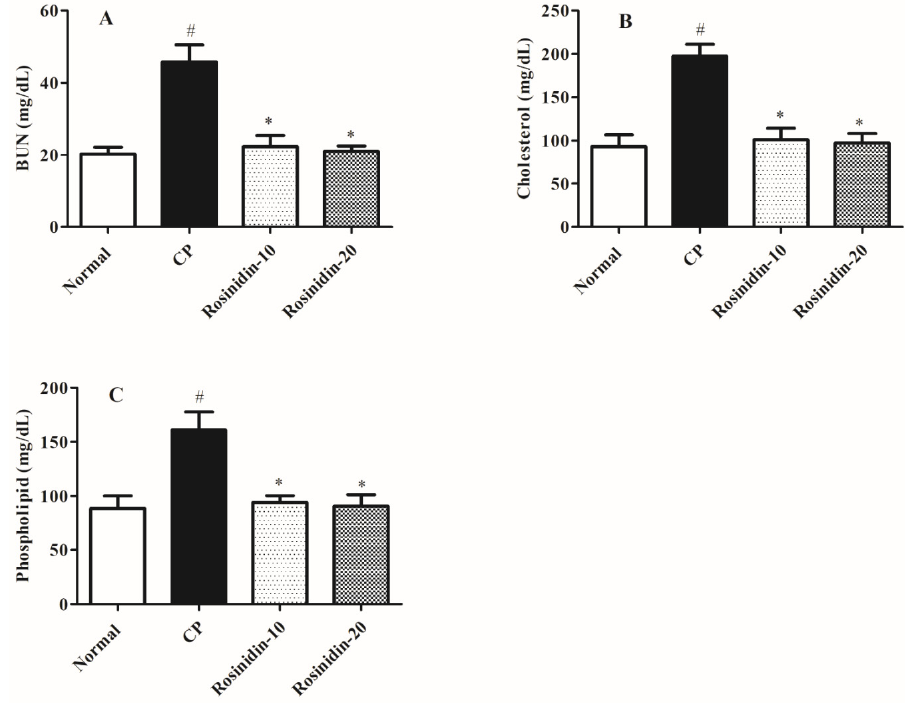
Figure 2. Effect of rosinidin on serum chemistry against cisplatin-induced nephrotoxicity in rats. ( A ) BUN ( B ) Cholesterol ( C ) Phospholipid; Data were presented as mean ± SEM ( n = 6). # Indicate significant alteration for normal vs. control, * indicated modulations observed in rosinidin vs. cisplatin. p value less than 0.05 were considered statistically significant. The analysis was carried out by employing the Kruskal–Wallis test.